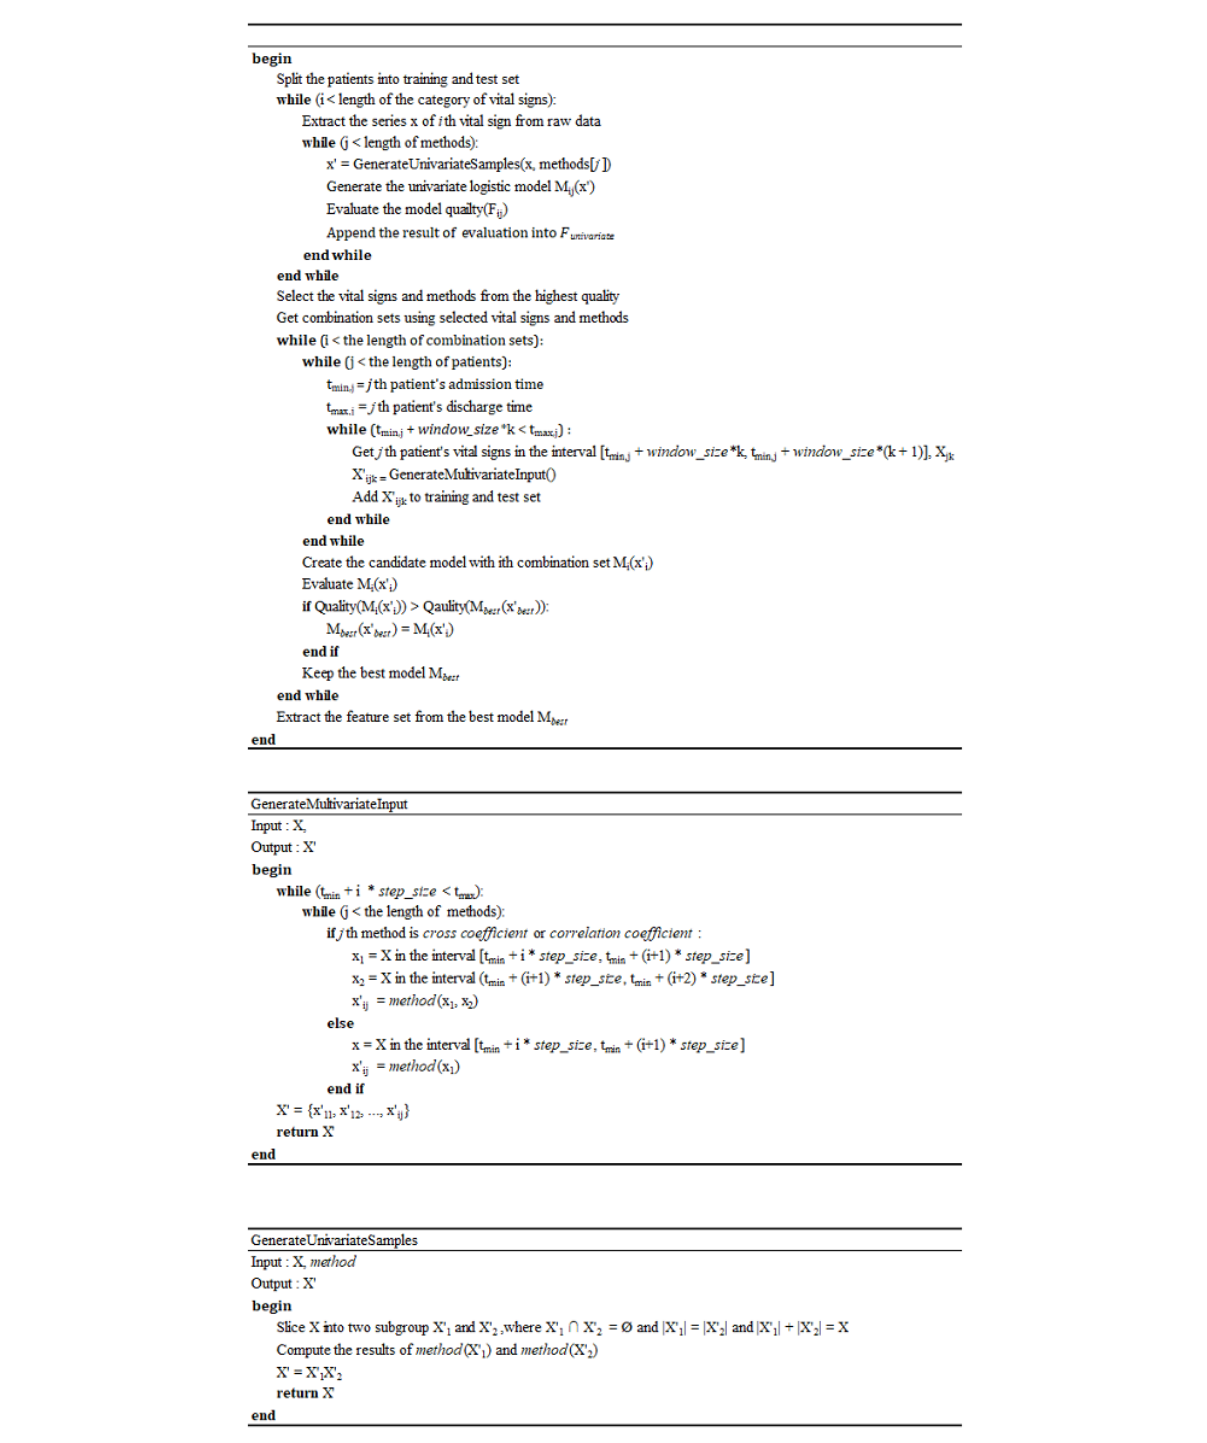
Figure 1. Proposed feature selection